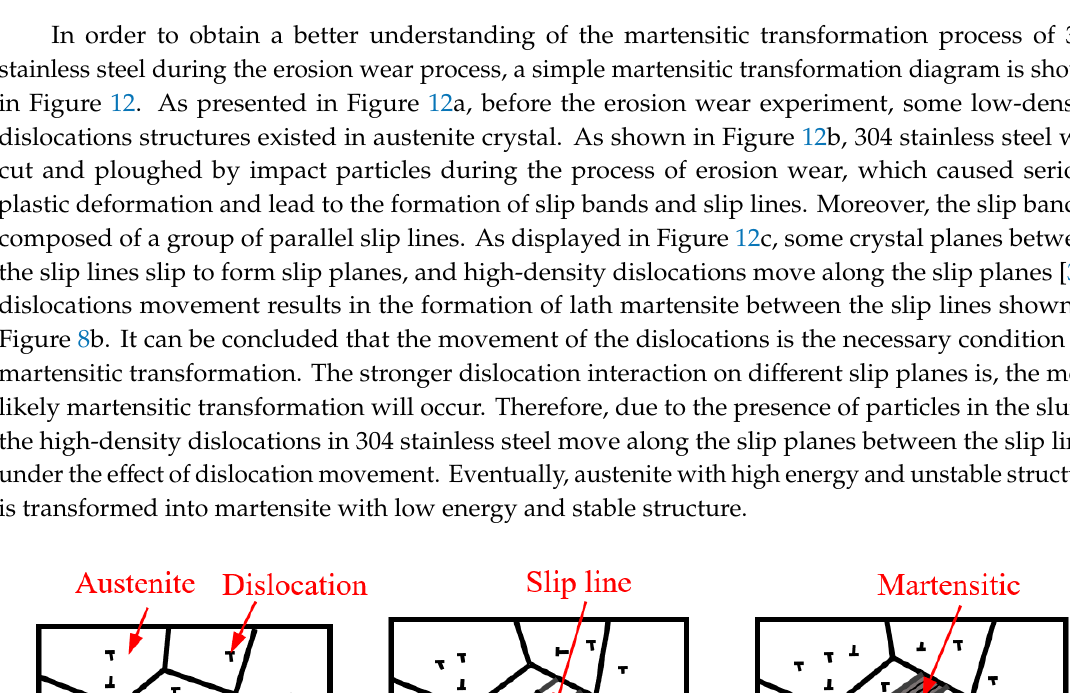
Figure 11. Diagram of relationship between Gibbs free energy and temperature of austenite and martensite.